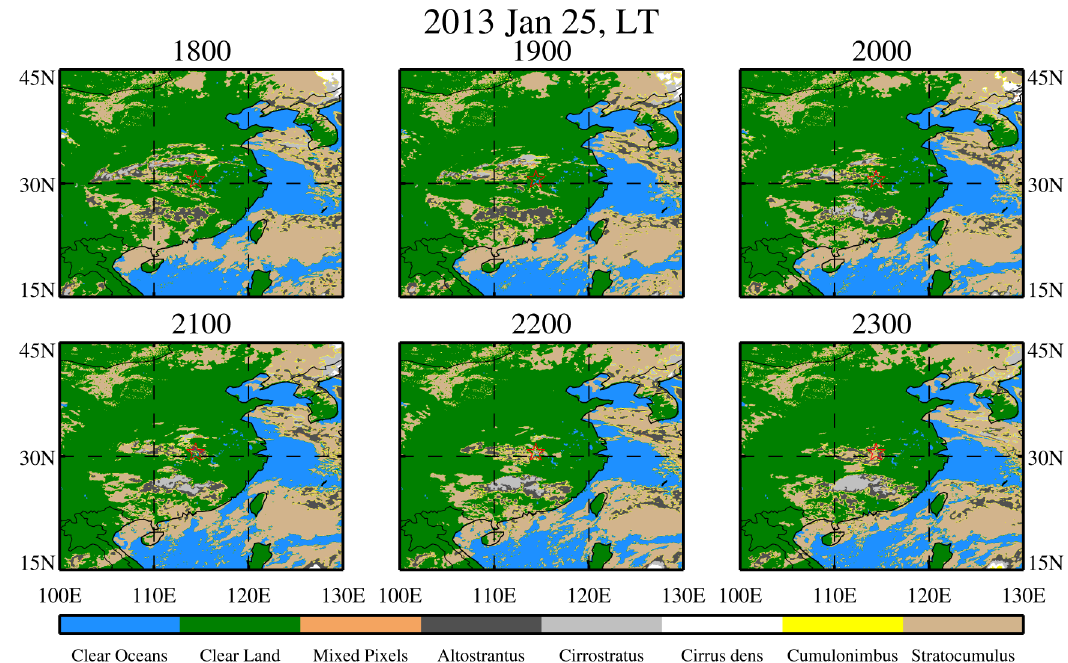
Figure 2. Hourly cloud classification satellite image from the FY-2E geostationary meteorological satellite from 1800 LT to 2300 LT on 25 January 2013. The red star denotes the location of Wuhan. Note that the development of stratocumulus is from dispersion to concentration around Wuhan.